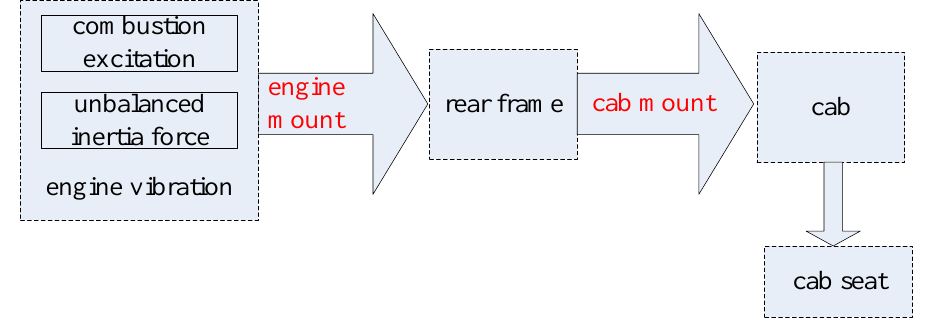
Figure. 2 The vibration transmission path of an engine. Figure 2. The vibration transmission path of an